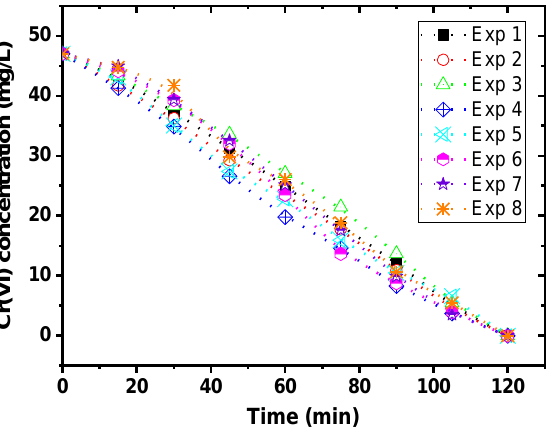
Figure 2. Concentration of Cr(VI) as a function of time for eight experiments using the same conditions (U = 9 kV, ∆ t = 500 µ s, f = 50 Hz, 2 mm gap, electrode length = 0 ± 10 µ m, 47 mg/L, σ = 4 mS/cm, pH = 2.4). Uncertainty is equal to 1% (not shown).